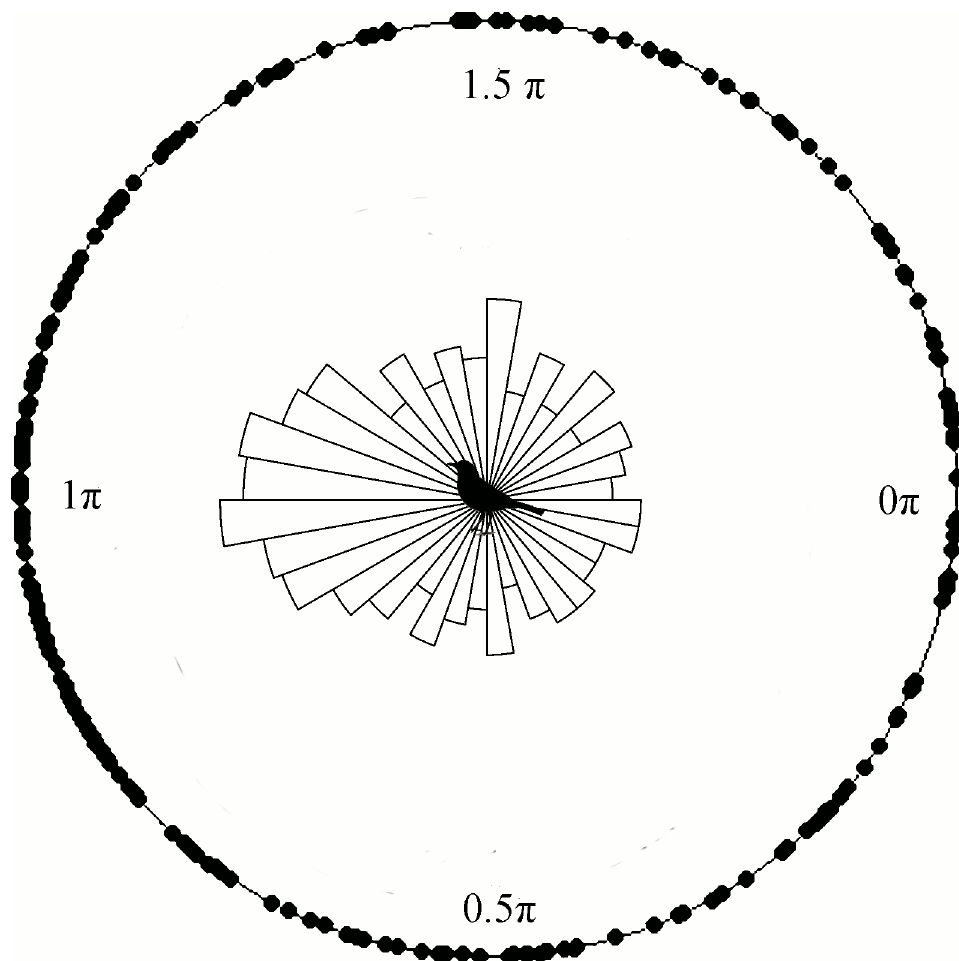
Fig 5. Distribution of turning angles. Black points around the circle represent the relative angle observations. Note the high frequency of angle values of +180° or − 180° ( π or - π radians), which represents more abrupt turns and is characteristic of tortuous